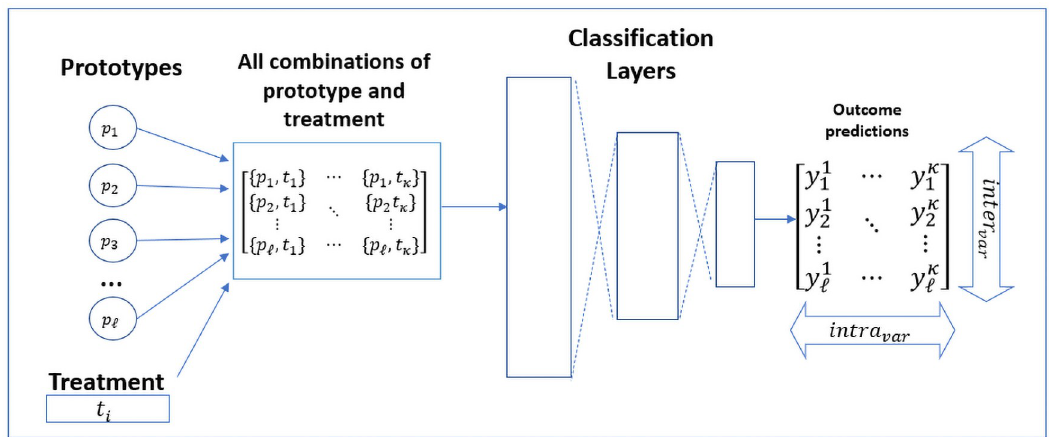
Fig 2. Visualisation of L 3 ’s